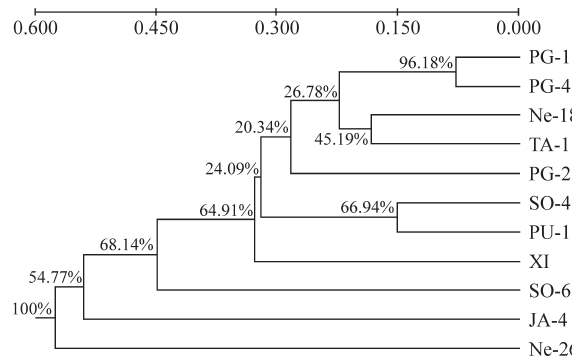
Figure 3 - Pattern of genetic divergence of 11 Brazilian Oryza glumaepatula populations based on eight microsatellite loci and un- weightedpairgroupmethodwithaverages(UPGMA)clusteringwithsim- ilarities obtained from Nei’s distances (1978).